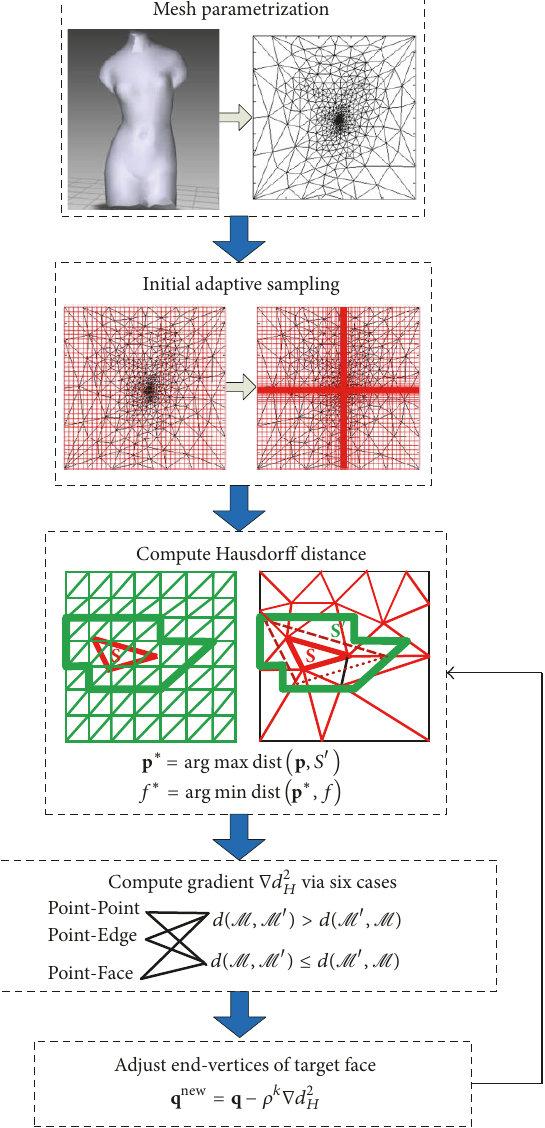
Figure 1: A framework for Hausdorff error driven geometry